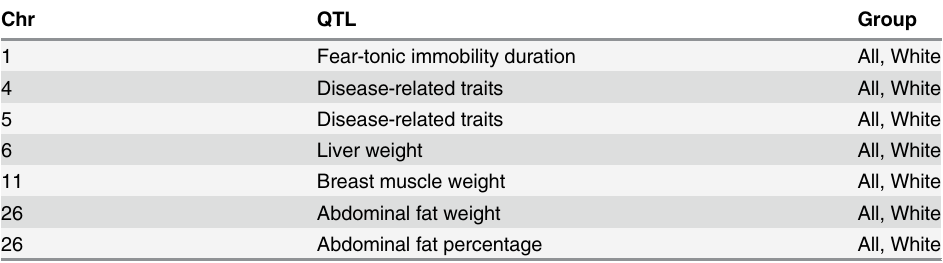
Table 3. QTL associated with productive traits in FLK analysis in all three studies. ‘ All ’ stands for inclusion of all commercial breeds, and ‘ White ’ for analysis within white layers. Chr QTL Group